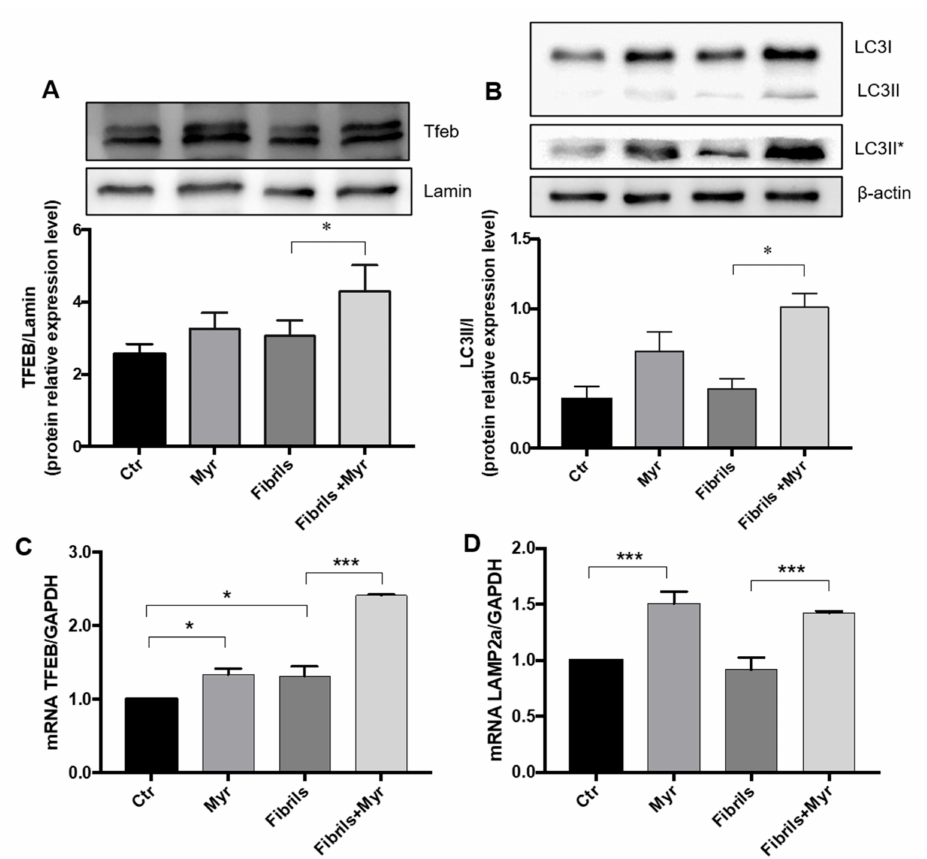
Figure 3. Myr treatment induced TFEB nuclear translocation and autophagy in the PD cell model. Quantification of nuclear translocation of TFEB by Western blot analysis normalized to β -lamin ( A ). Quantification of LC3II/I ( B ) protein expression by Western blot analysis on whole lysates, normalized to β -actin. Protein signals were quantified by densitometric analysis. LC3-II* indicates a longer exposure. Quantification of TFEB ( C ) and LAMP2a ( D ) gene transcription by qRT-PCR in cells treated with 0.5 µ M α -syn fibrils for 24 h with or without 50 µ M Myr pretreatment. GAPDH was used as a housekeeping gene. All data are expressed as mean ± SEM (* p < 0.05; *** p < 0.001); one-way ANOVA test followed by Bonferroni correction was used for all